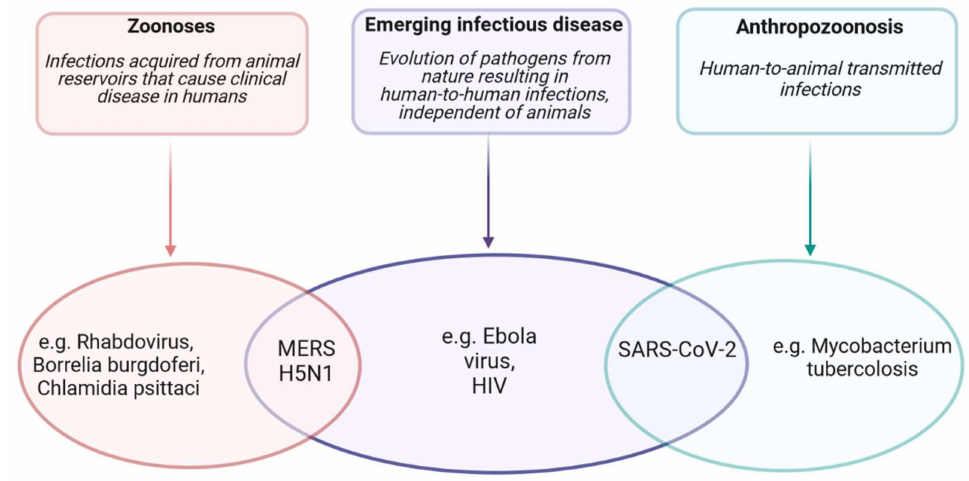
Figure 3. SARS-CoV-2 spillover to humans hypotheses. Spillover to humans can result from three different processes: zoonoses in which pathogens are transmitted from the animal reservoir directly (such as Rhabdovirus or Chlamydia psittaci) or indirectly (e.g., via vectors such as Borrelia burgdorferi) to humans causing disease. Emerging infectious diseases in which pathogens can evolve from animals and cause an emerging disease of human infection that is characterized by human-to- human transmission independent of animals (e.g., Ebola virus and HIV). Anthropozoonosis which is an infection transmitted from human to animal (such as Mycobacterium tuberculosis infection). Some pathogens may fall into more than one category: MERS and H5N1 are both zoonoses and emerging infectious diseases. The SARS-CoV-2 infection has characteristics of both an emerging infectious disease and an anthropozoonosis, but from this point of view, it is not considered a zoonosis because no animal is found as a reservoir, and human infection can only occur by human-to-human